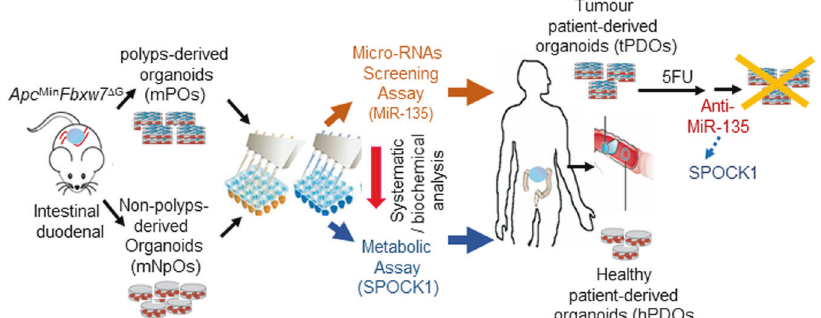
Fig. 7 Graphical abstract and highlights. The tumour and adjacent non-tumour organoids bear differential metabolic activity. Murine Apc Min Fbxw 7 Δ G duodenal polyp-derived organoids mimic colorectal cancer patient-derived organoids. MiR-135b adapts cellular metabolism by targeting SPOCK 1. MiR-135 and SPOCK1 synergistically in fl uence tumour cell metabolism and drug